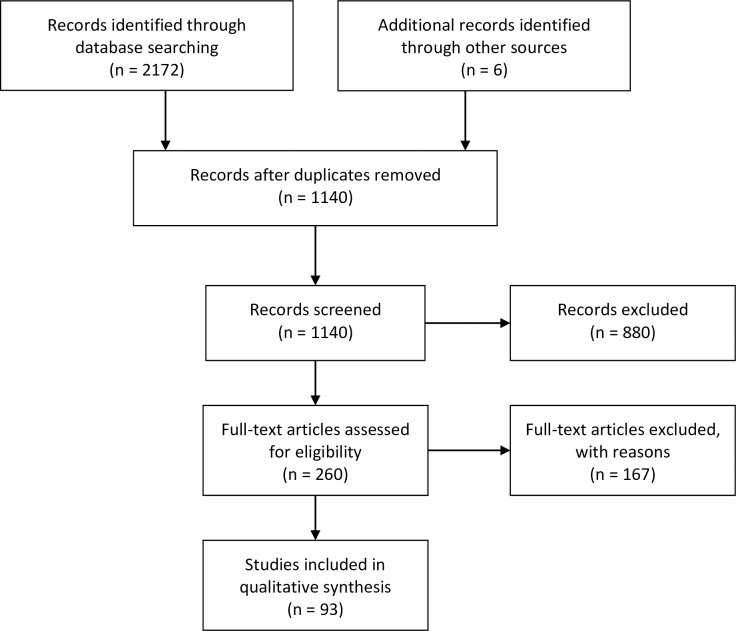
PRISMA flow diagram detailing inclusion and exclusion of records.93 studies were included from 2172 records initially screened through database searching, and 6 records identified through supplemental searching.